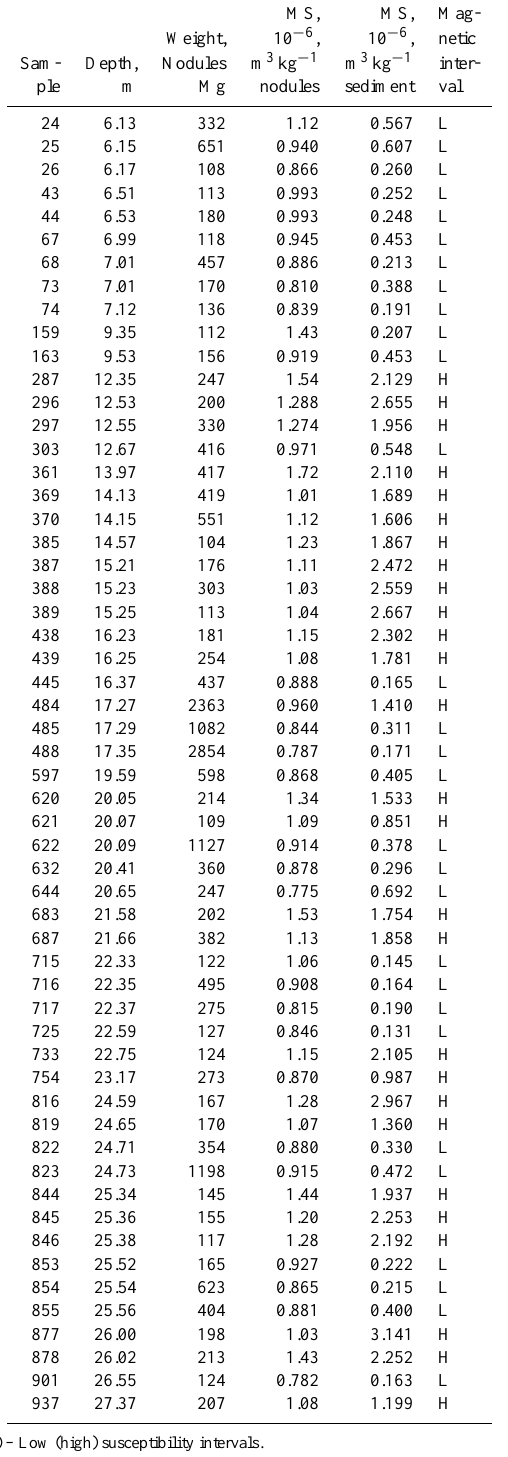
Table 3. Magnetic susceptibility of vivianite nodules.